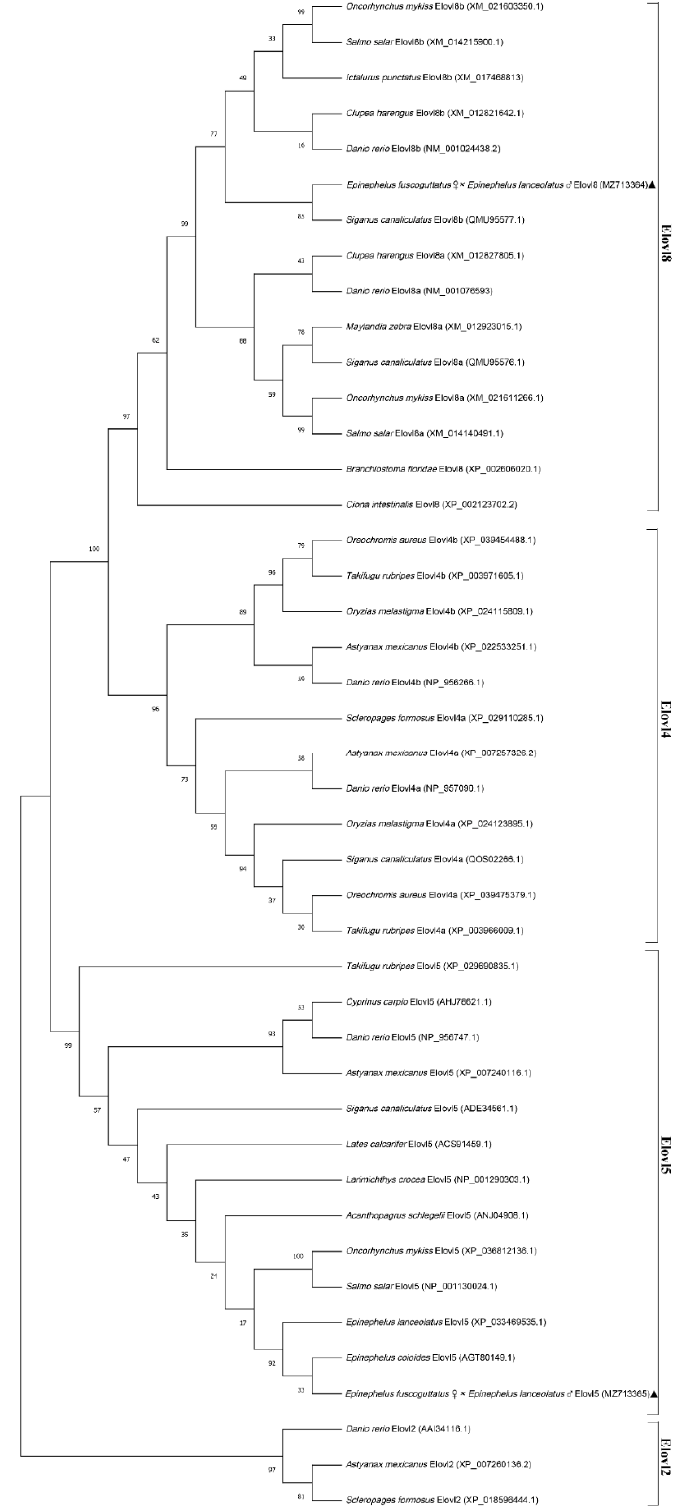
Figure 4. Phylogenetic tree analysis constructed by using the full-length amino acid sequences of Elovl8, Elovl4 and Elovl5. The full-length amino acid sequence of Elovl8, Elovl4 and Elovl5 proteins were extracted from Genbank and analyzed using the maximum likelihood method by Mega x with 1000 bootstrap replications. Elovl2 is regarded as the outgroup. The numbers shown at branches indicated the bootstrap values (%). Our Epinephelus fuscoguttatus ♀ × Epinephelus lanceolatus ♂ sequence was marked “ ▲ ”.